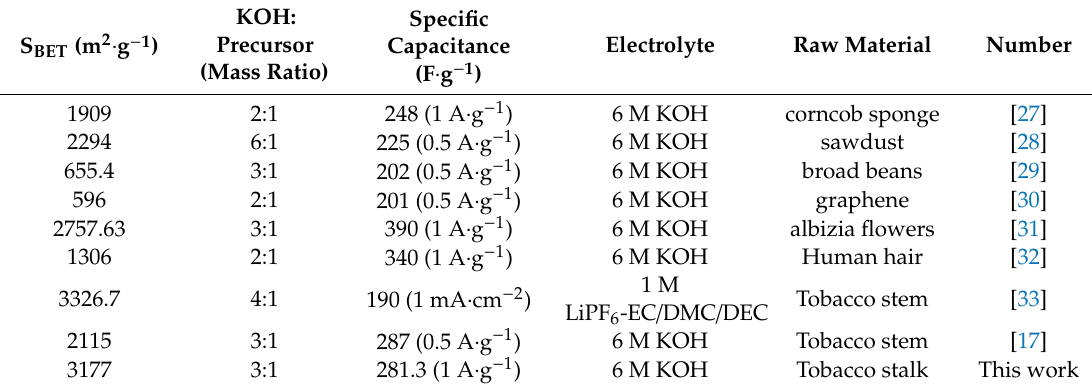
Table 2. Comparison of the specific surface area and electrochemical performance of biomass-activated carbon materials with ATC-3.